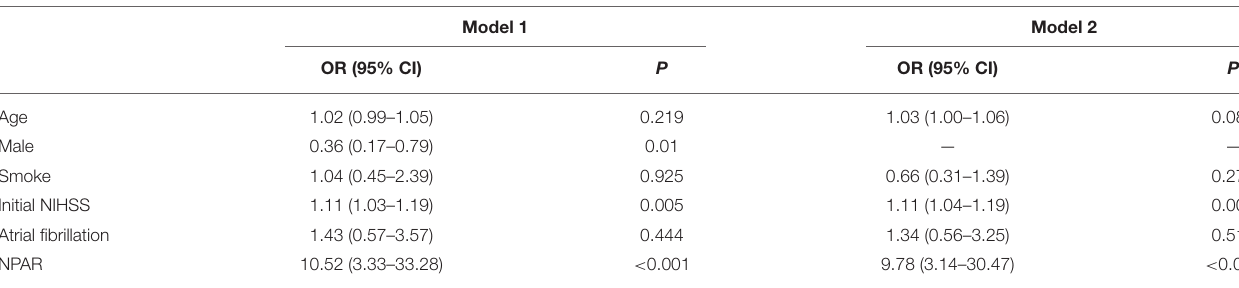
TABLE 2 | Multivariable analysis of possible predictors of